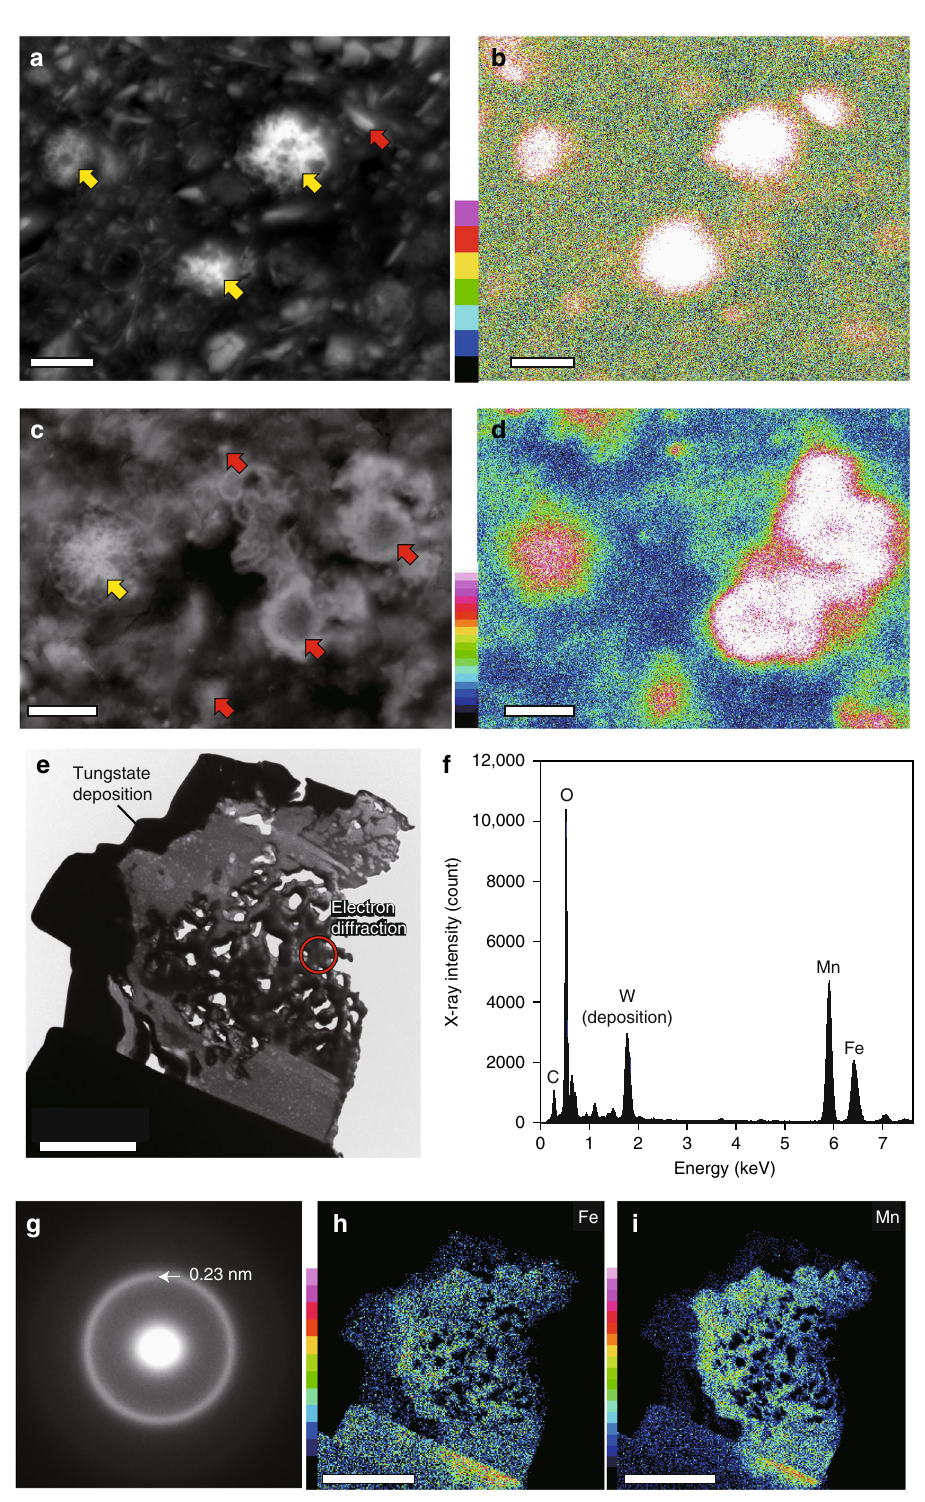
Fig. 2 Composition and mineral characteristics of Mn-microparticles. a – d Representative elemental map of manganese in a resin-embedded sediment sample. Scale bars, 5 μ m: a A back-scattered electron (BSE) image acquired by scanning electron microscopy (SEM) and b an energy-dispersive X-ray spectroscopy (EDS) elemental map of manganese for sample U1365D-1H-2 0/20; c A back-scattered electron (BSE) image acquired by SEM and d an elemental map of manganese for sample U1365D-9H-3 35/55; yellow arrows indicate Mn-microparticles, and red arrows indicate manganese- concentrated particles without concentric growth structure and fi brous structure in the samples herein. e – i Representative transmission electron microscopy (TEM) analysis results for Mn-microparticles. Scale bars, 2 μ m: e cross-sectional TEM image of an FIB-cut Mn-microparticle, and f an EDS spectrum; the W peak is an artifact derived from contaminated W-deposition during focused ion-beam (FIB) fabrication. g Electron diffraction pattern. h , i Elemental maps for Fe and Mn, respectively, in sample U1365C-1H-2 0/20. Based on the EDS spectrum and electron diffraction pattern, the main constituent is poorly crystalline ferromanganese